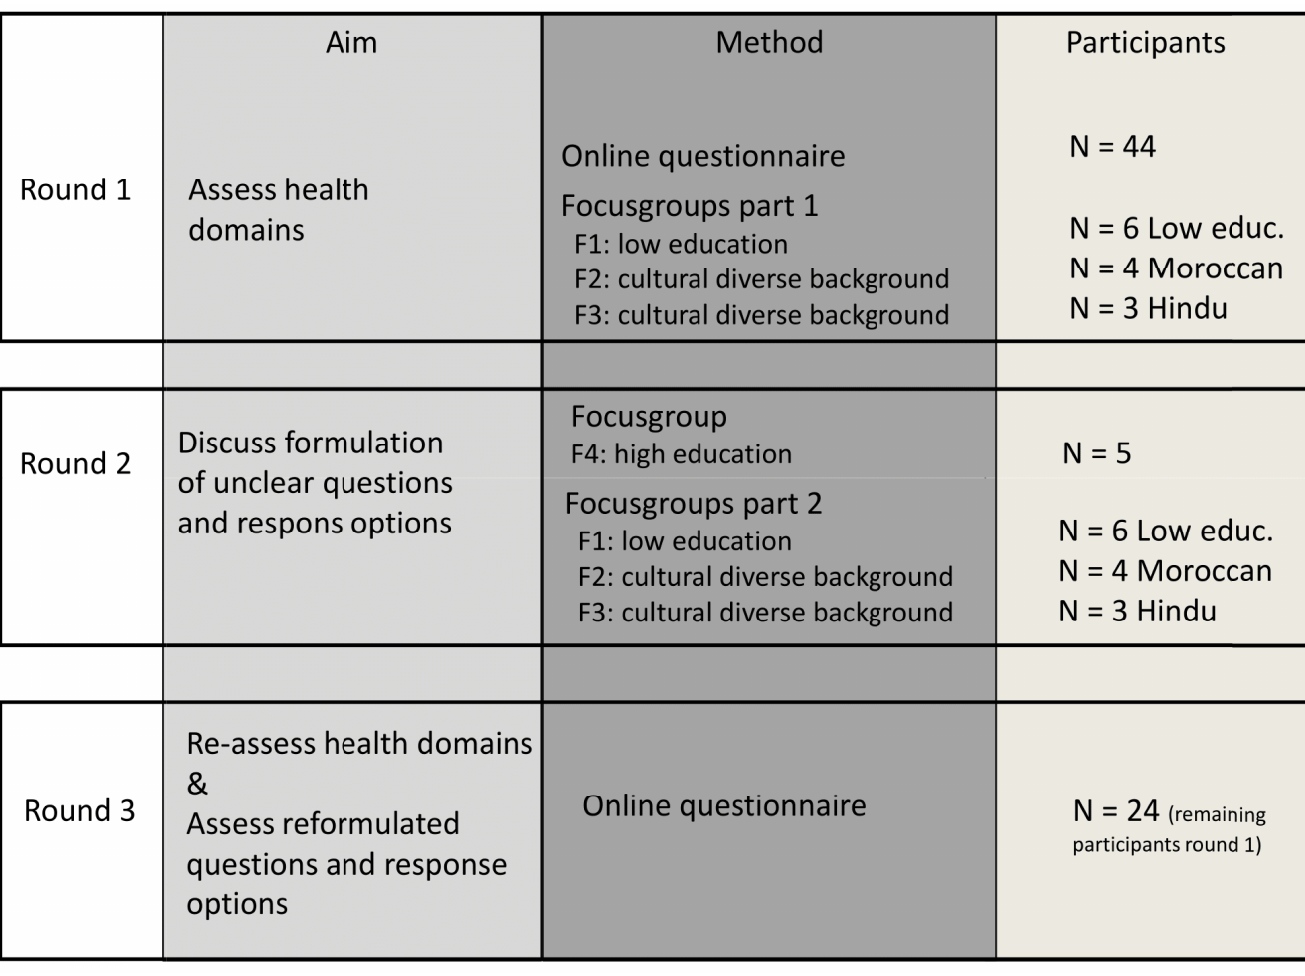
Fig 1. Design of the Delphi